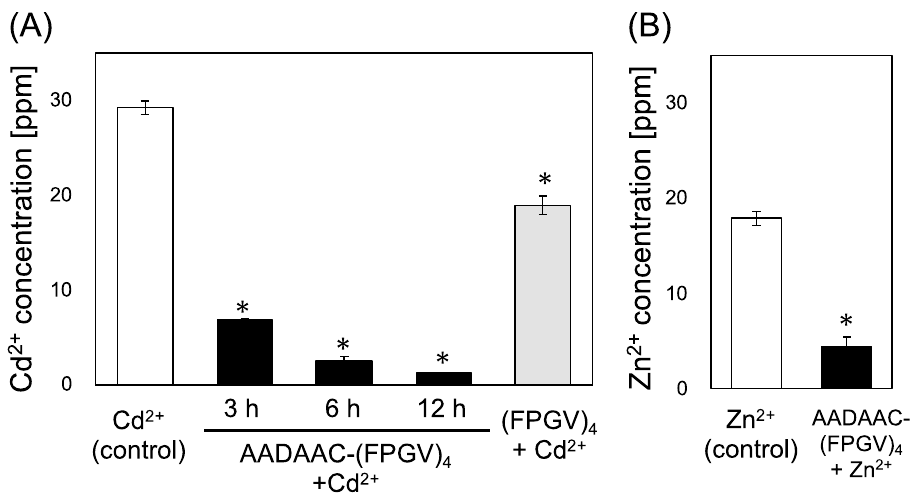
Figure 9. Metal binding affinity of AADAAC-(FPGV) 4 . ( A ) The concentration of Cd 2+ in the supernatant of CdCl 2 solution (0.236 mM) was measured 3 h, 6 h, and 12 h after treatment with AADAAC-(FPGV) 4 at a concentration of 1.0 mg/mL (black bars). Cd 2+ concentration in the solution 12 h after treatment with the same concentration of (FPGV) 4 was also shown (gray bar). ( B ) The concentration of Zn 2+ in the supernatant of ZnCl 2 solution (0.236 mM) was measured 12 h after treatment with AADAAC-(FPGV) 4 at a concentration of 1.0 mg/ mL. The molar concentration ratio of AADAAC-(FPGV) 4 and metal ion was 2:1. * P < 0.01, concentration after treatment with the peptide compared to that of the control ( t